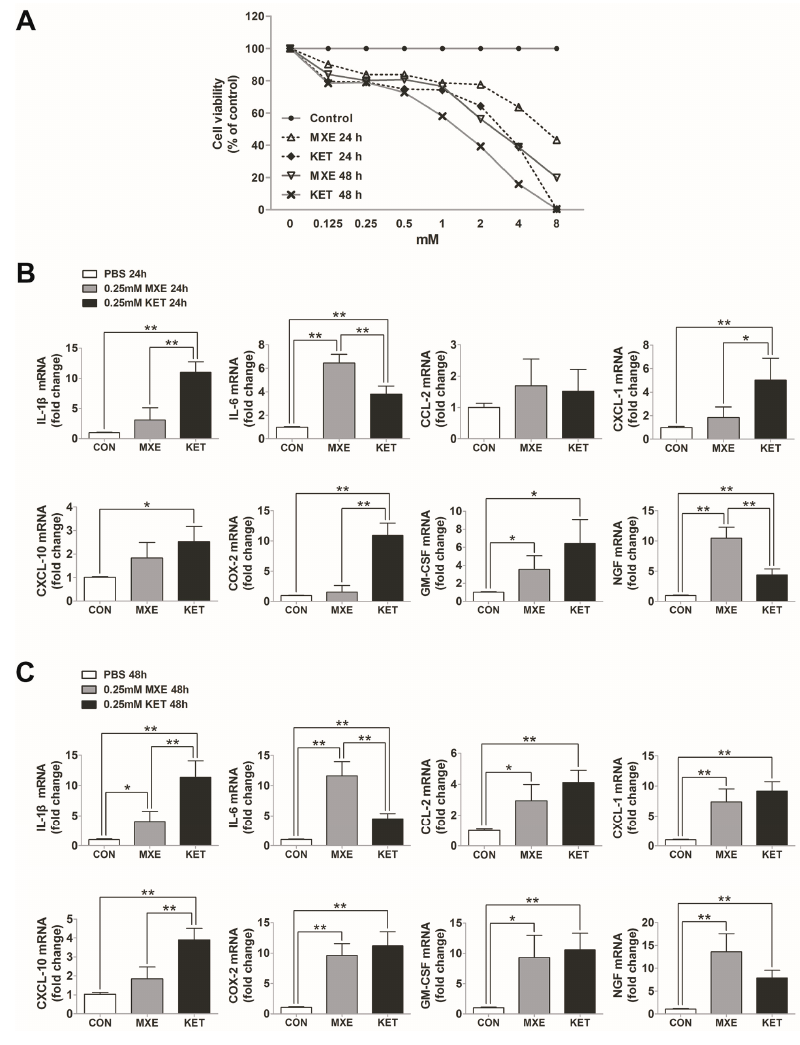
Figure 9. Direct toxic and pro-inflammatory effects on bladder epithelial cells in vitro. ( A ) CCK-8 assay results for SV-HUC-1 cell viability. Expression of genes for cytokines/chemokines, including IL-1 β , IL-6, CCL-2, CXCL-1, CXCL-10, COX-2, GM-CSF, and NGF in SV-HUC-1 cells stimulated with methoxetamine (MXE) or ketamine (KET): for 24 h ( B ); or 48 h ( C ). Data are expressed in mean ± SD, as the fold-change vs. the mean value in the control group at four weeks. One-way ANOVA were used for analysis. * p < 0.05, ** p <